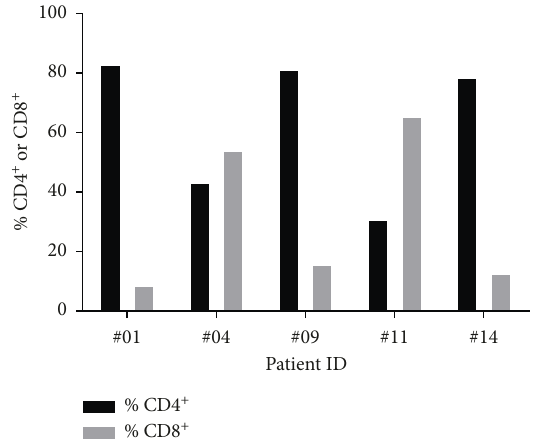
Figure 4: T cell populations after a TIL rapid expansion protocol (REP). CD4 + and CD8 + TILs were analysed by flow cytometry after 14 days in a